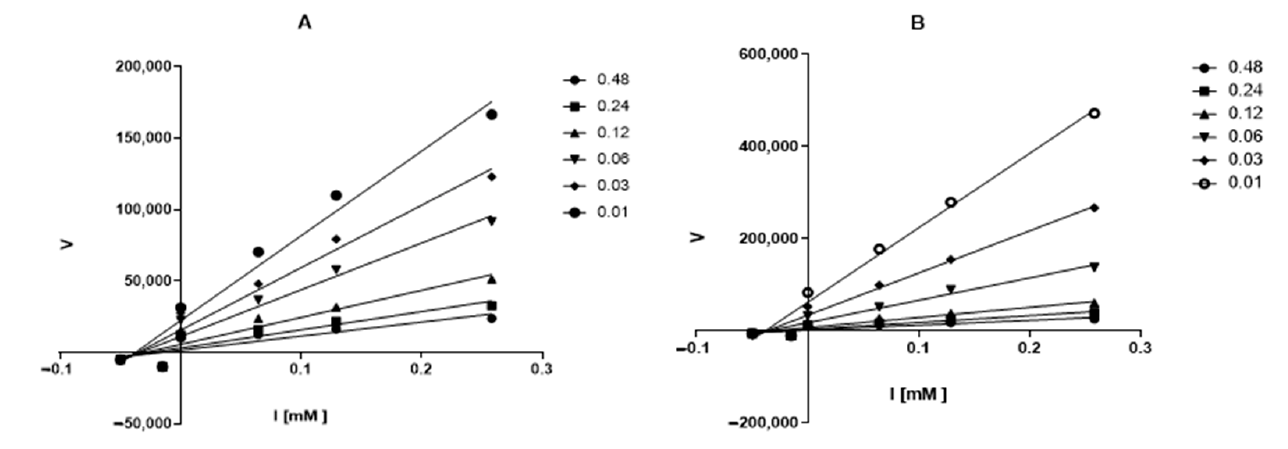
Figure 5. Dixon’s plot obtained for AChE in presence of increasing concentrations of ceanothanes 3 ( A ) and 7 ( B ). The initial compound concentration of compounds 3 ( A ) and 7 ( B ) was 0.48 µM and was subsequently diluted to get the set concentration of 0.01, 0.03, 0.06, 0.12 and 0.24 µM. [AChE] = 0.25 U/mL .